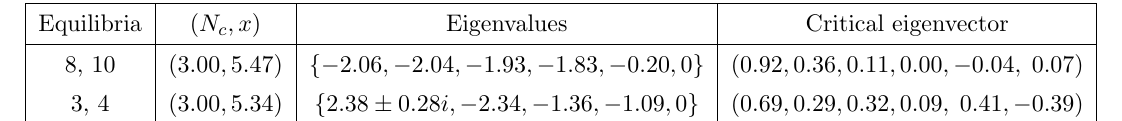
Table 6. Eigenvalues and critical eigenvectors crossing marginality of the saddle-node bifurcation with non-trivial (cid:11) g ; (cid:11) y at N c = 3.